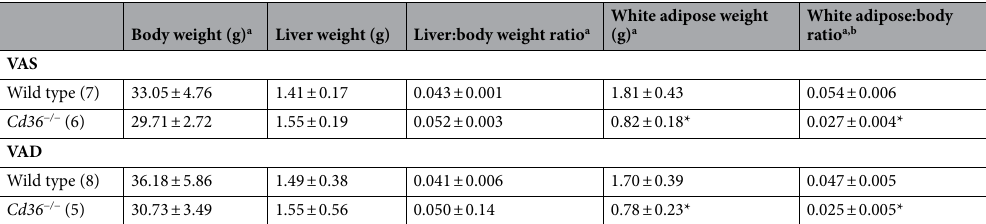
Table 2. Physical characteristics of WT and Cd36 −/− mice consuming diets with varying vitamin A content. The n number for each experimental group is provided in parentheses in the first column. All data are presented as mean ± SD. Data analyzed by two-way ANOVA. *Post-test significantly different between genotypes within mice consuming the same diet. a Significant genotype effect. b Significant diet